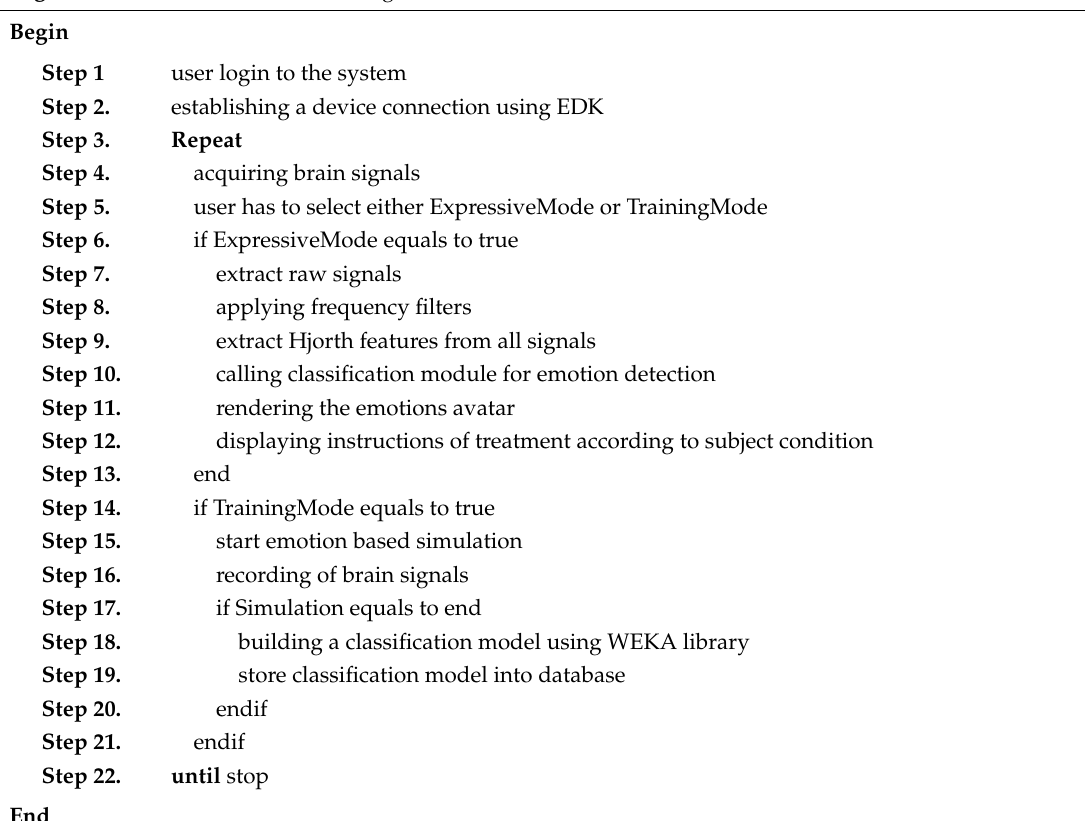
Algorithm 1. CAES in real time